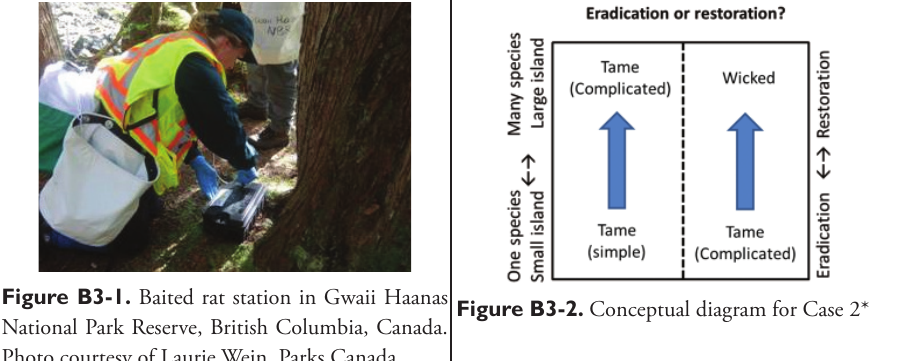
Figure B3-2. Conceptual diagram for Case